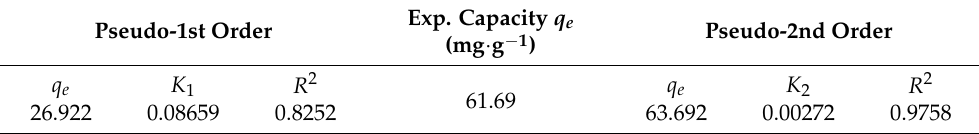
Table 4. Kinetic factors of Co 2+ adsorption upon